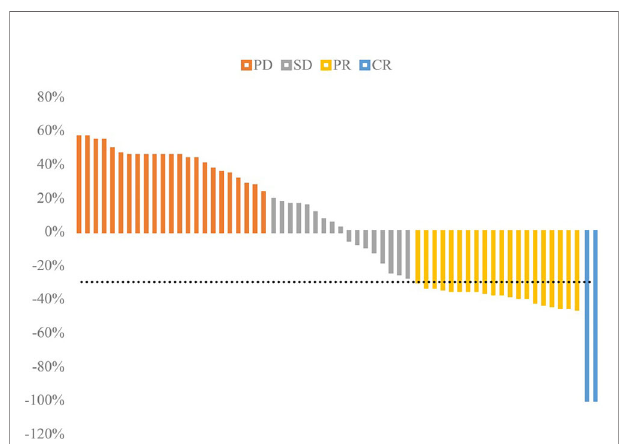
TABLE 3 | Bivariate and multivariable Cox proportional hazard modeling analyses for overall survival. Variable Bivariate analysis